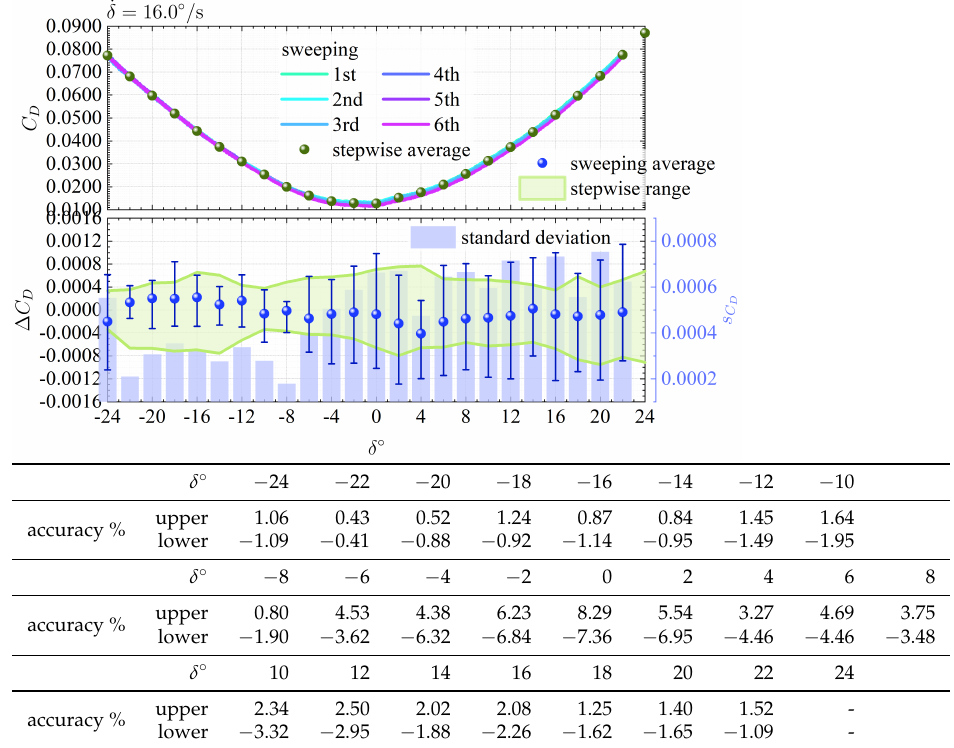
Figure 8. The results from a preliminary attempt in the sweeping mode under the conditions of ˙ δ = 16.0 ◦ /s, U ∞ = 40 m/s, and α = 0 ◦ compared with that in the stepwise mode.